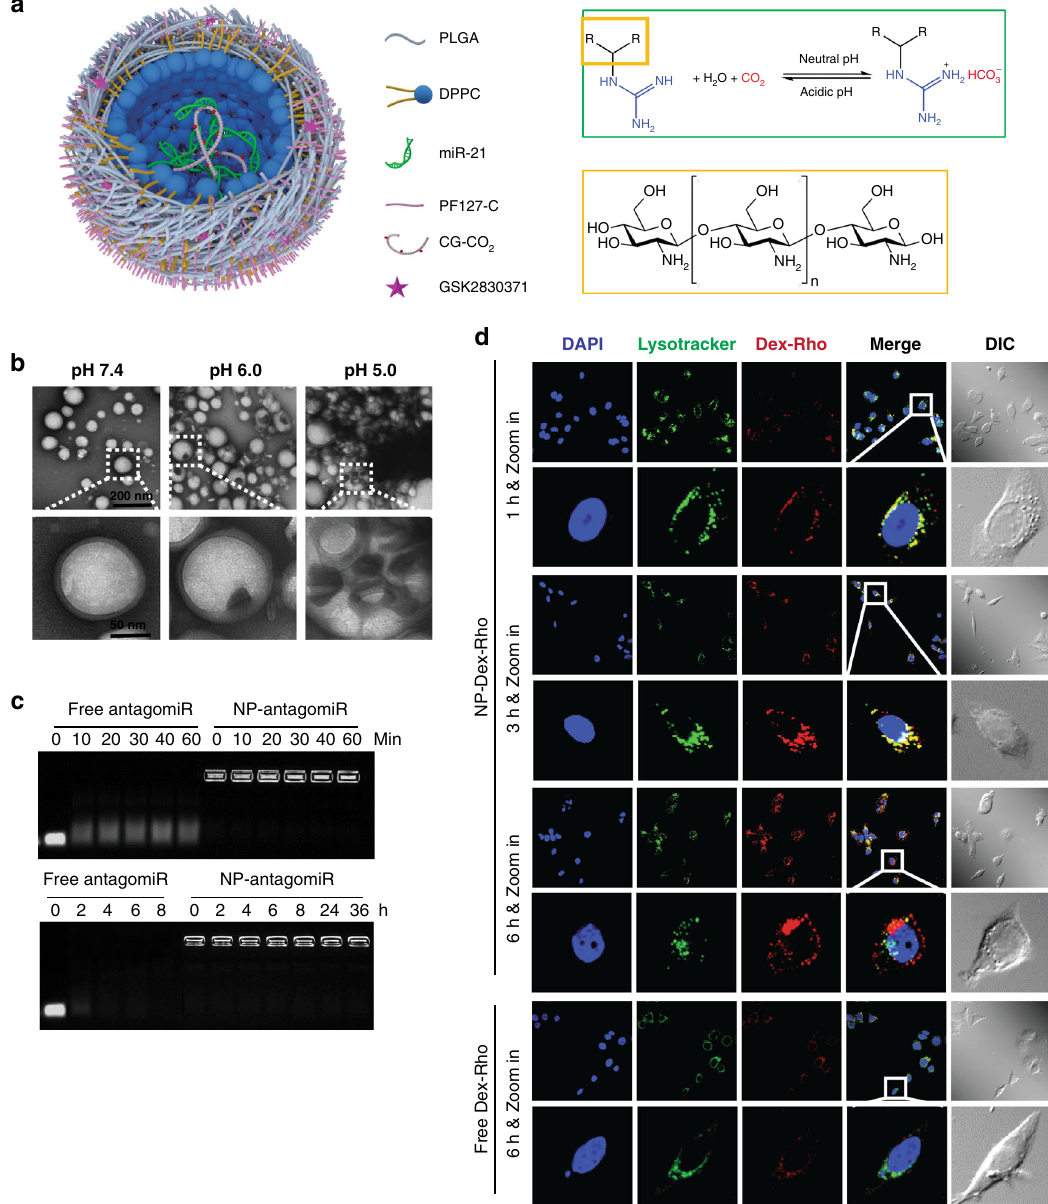
Fig. 7 Synthesis of nanopariticles for drug delivery. a Nanoparticles encapsulating therapeutic agent(s) were synthesized using a double-emulsion water-in- oil-in-water method. The inner water phase containing anti-miR21 inhibitor and CG-CO 2 were encapsulated in the core, and hydrophobic WIP1 inhibitor (GSK2830371) together with PLGA and DPPC dissolved in oil phase was used to form the shell structure. b TEM images of nanoparticles in pH 7.4, 6.0, and 5.0, respectively. Nanoparticles maintained spherical morphology with clear core-shell structure in pH 7.4, and enlarged and broken under low pH (pH 6.0 and pH 5.0) indicated the pH-responsive behavior. c Electrophoretic stability assay of in-MW@NP and free anti-miR21 inhibitor at different incubation time points in serum at 37 °C. The observable signal of in-MW@NP indicated that the nanoparticle encapsulation could protect anti-miR21 inhibitor from degradation in serum up to 36 h. d Typical confocal imaging of cells incubated with Dex-Rho@NP for 1 – 6 h. The change of the fl uorescence overlap of Dex-Rho (red) and Lysotracker (green) shows the CO 2 -associated pH-responsive endo/lysosomal escape in HER18R cells. Cell nuclei were stained with DAPI (blue), endo/lysosomal vesicles were stained with LysoTracker Green, and DIC represented differential interference contrast. Data are representative of 3 independent